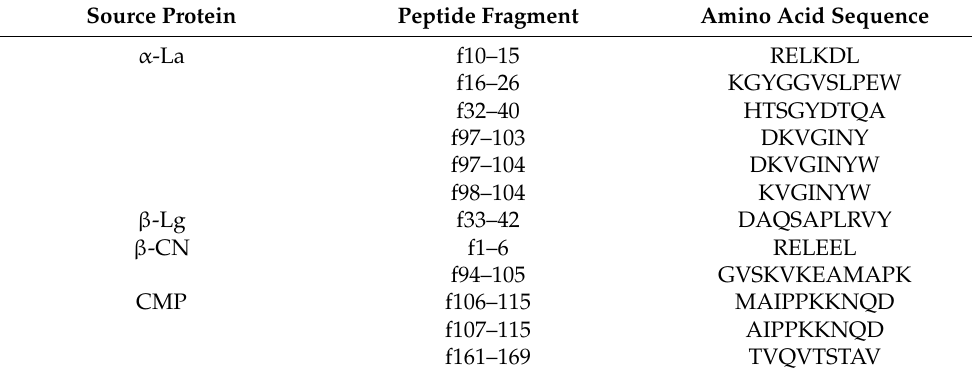
Table 3. Identification of peptides of WPC hydrolyzed